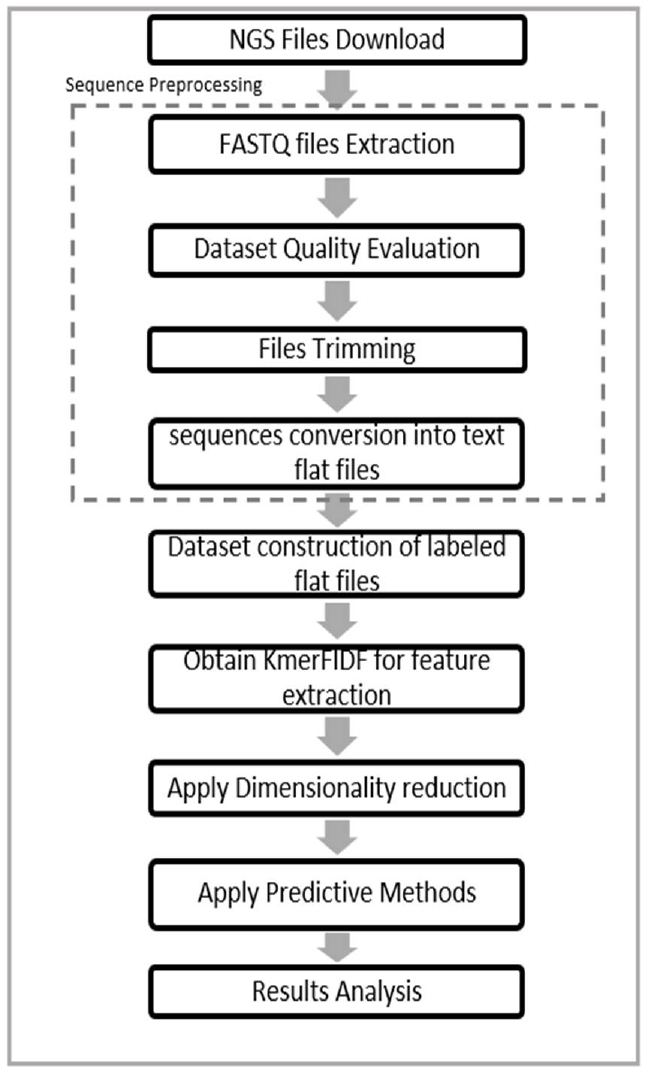
Figure 5. The implemented model using traditional predictive machine learning methods (Model_0).